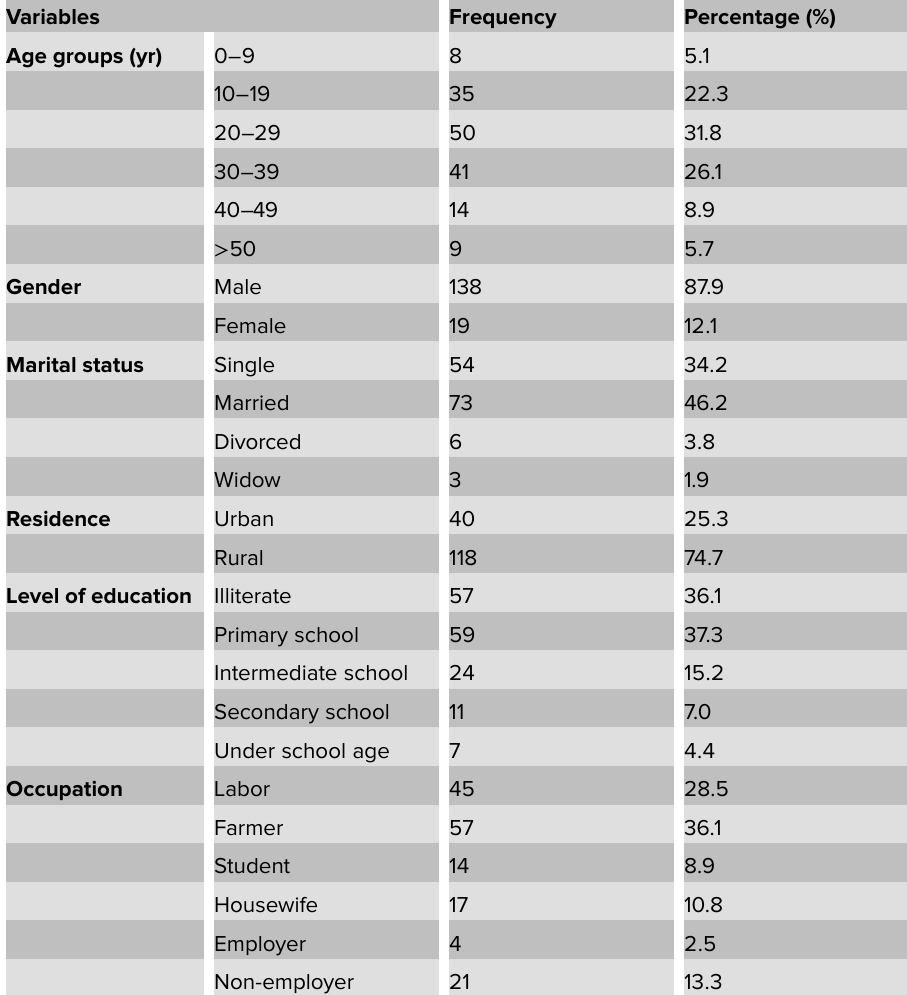
Table 1: Patient characteristics ( N =